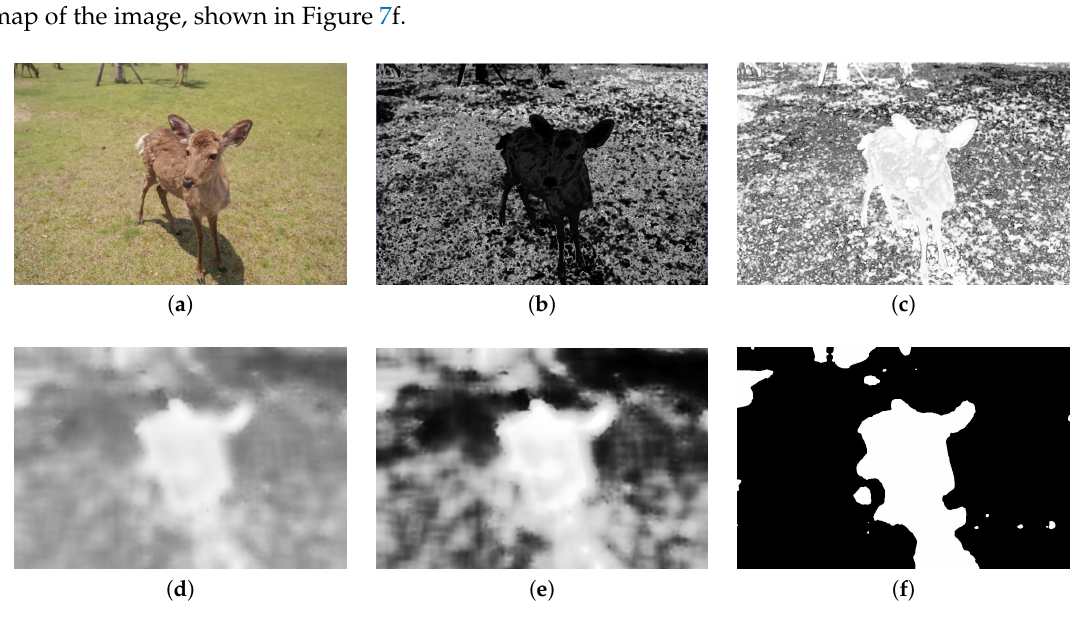
Figure 7. ( a ) Original figure. ( b ) Back-projecting result. ( c ) Reversed result of ( b ). ( d ) Mean shift result of ( c ). ( e ) Result of ( d ) after histogram equalization. ( f ) The saliency region.